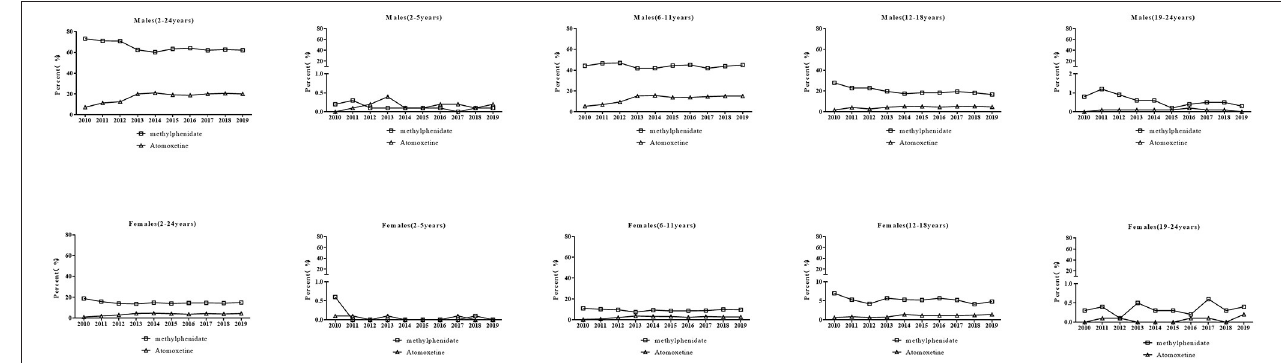
FIGURE 3 | ADHD drug use stratified by age and